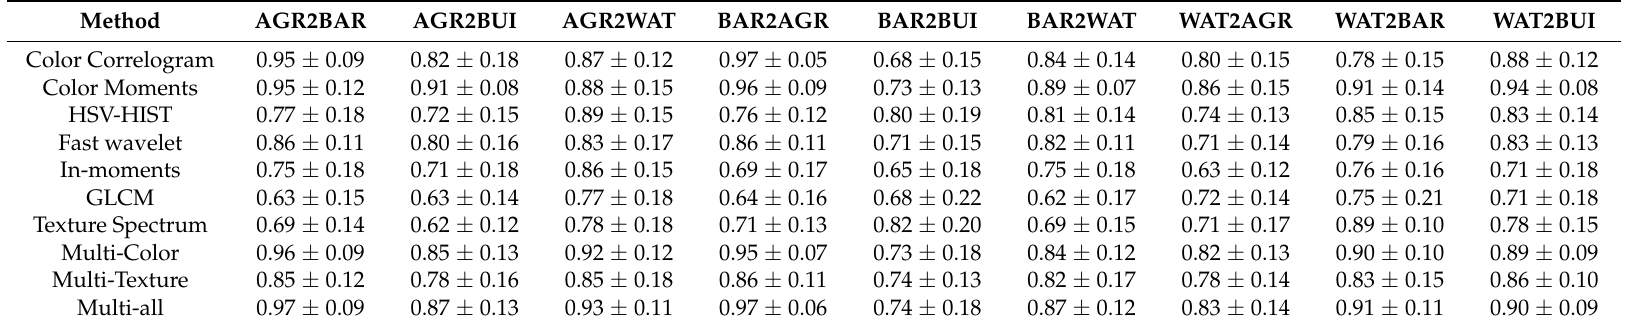
Table 6. Comparison of different methods: Mean Average Precision for nine kinds of ground change classes ( i = 2).